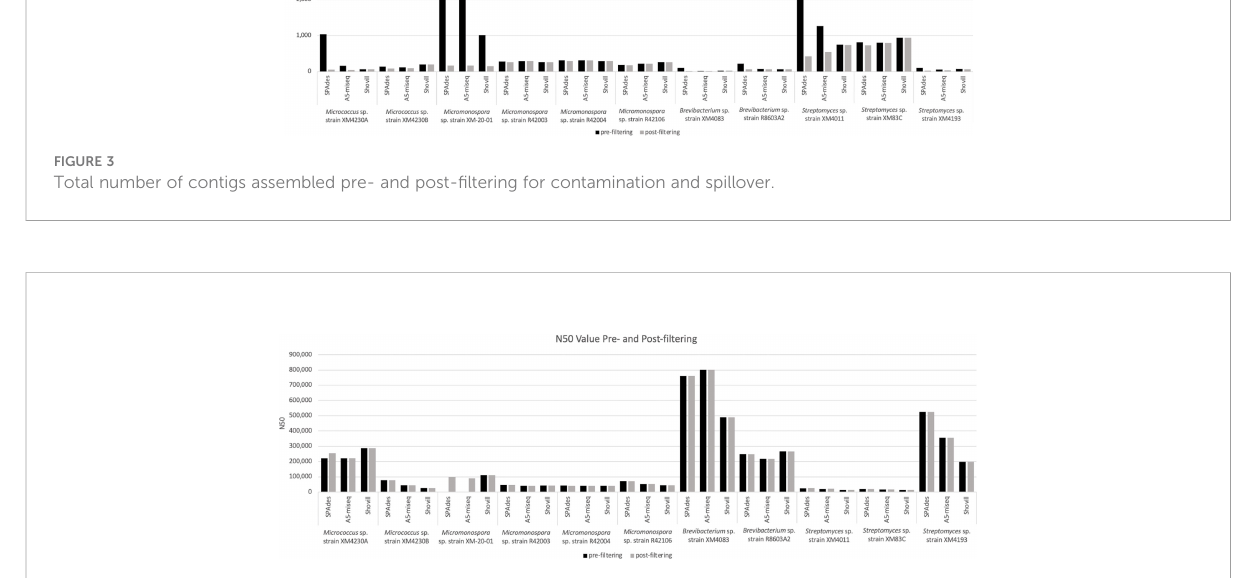
FIGURE 4 N50 values calculated for genome assemblies pre- and post- fi ltering for contamination and spillover. Note: the pre- fi ltering N50 value for XM-20-01 assembled with SPAdes is 1,606 and assembled with A5-miseq is